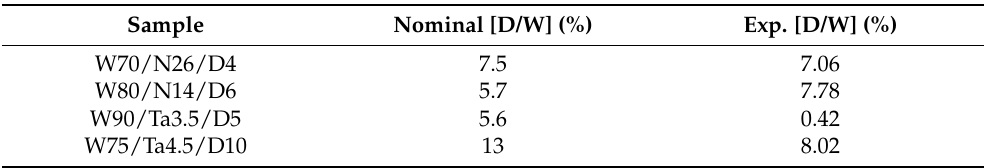
Table 4. Semi-quantitative estimation of the D concentration in the four analyzed samples, compared to the nominal concentration given by the GDOES